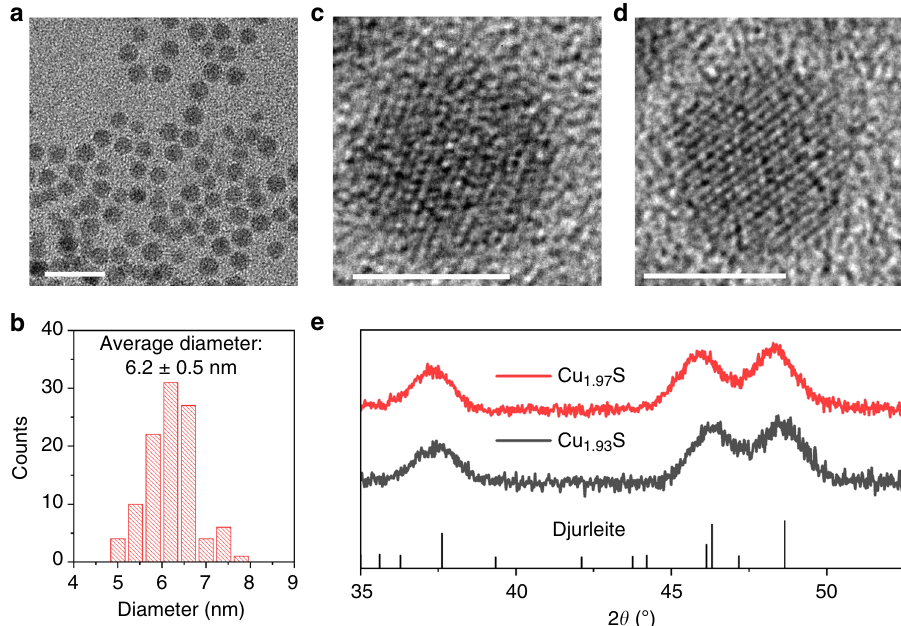
Fig. 7 Structural characteristics of Cu 1.93 S NCs prepared by post-synthetic air oxidation. a Wide- fi eld TEM image (scale bar = 20 nm) of Cu 1.93 S NCs synthesized by the hot-injection method and b histogram showing NC diameter distribution determined by ImageJ analysis of the TEM image in a . The average diameter of the NCs is determined to be 6.2 nm with a standard deviation of 0.5 nm. HRTEM image (scale bar = 5 nm) of a representative NC of c Cu 1.97 S and d Cu 1.93 S obtained from Cu 1.97 S by post-synthetic air exposure. e experimental PXRD patterns of Cu 1.97 S NCs and Cu 1.93 S NCs prepared by air oxidation of Cu 1.97 S NCs for 24 h. The reference pattern of djurleite phase (JCPDS # 23 – 0959) is shown by the stick plot. The sub-stoichiometry was estimated from the LSPR peak energy for the corresponding NCs (0.42 eV: Cu 1.97 S and 0.65 eV: Cu 1.93 S)